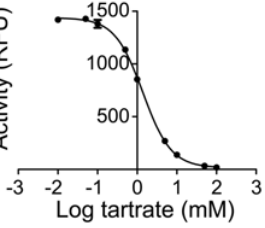
Figure 2. Inhibition of mPAP by L-( + )-tartrate. The indicated concentrations of L-( + )-tartrate were added to reactions (n=3 per concentration) containing mPAP (1 U/mL), 100 mM sodium acetate, pH 5.6 and the fluorescent acid phosphatase substrate DiFMUP. Relative fluorescence units (RFU). All data are presented as mean- s 6 s.e.m. Prism 5.0 (GraphPad Software, Inc) was used to generate curve.